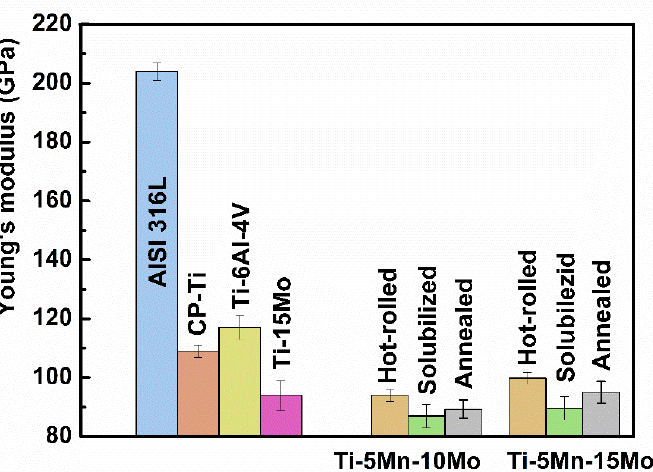
Figure 6. Comparison of Young’s modulus of the Ti-5Mn-10Mo and Ti-5Mn-15Mo alloys with commercial alloys under all processing conditions.